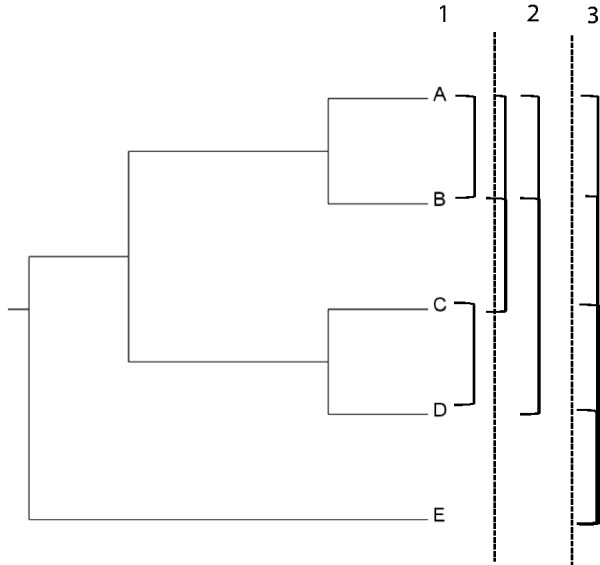
Example schematic diagram for identification of CNSs for all pairs of species. This schematic example with five species (A–E) shows how the pairwise searches are performed to determine the union of CNSs for each pair of species and separate lineages. In the example, the searches are performed in three levels (1–3). The bars on the right side connecting species represent separate searches. For all the species used in the analysis, a total of 105 searches were performed in a similar manner to determine the CNSs present in all pairs.